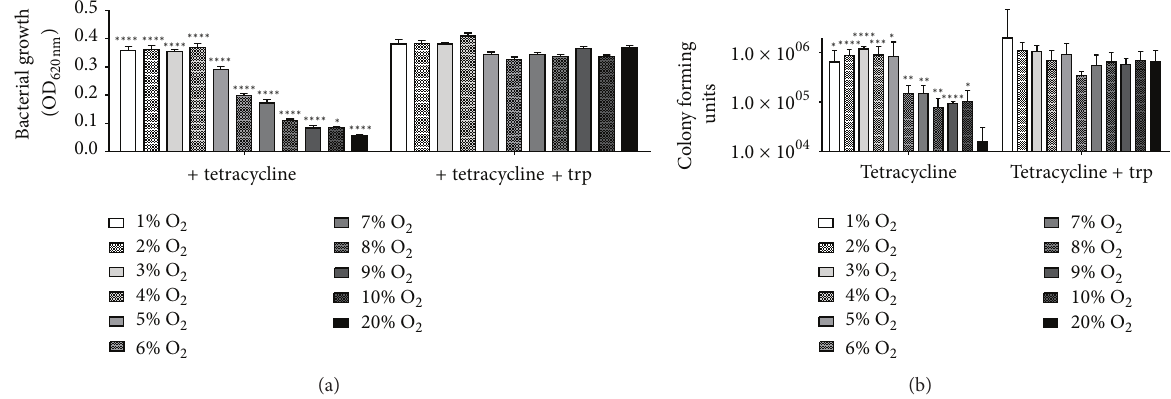
Figure 5: Loss of TDO-mediated antibacterial functions in HeLa-hTDO cells under low oxygen conditions. Infection experiments: HeLa- hTDO cells were incubated under different oxygen conditions (1–20% O 2 ) for 72 h with or without tetracycline (160ng/mL) and afterwards infected with Enterococcus faecalis in the presence or absence of additional tryptophan. (a) After 24 h the bacterial growth was determined by measurement of OD 620 nm , in 3 independent experiments with three replicates each. (b) Determination of colony forming units by serial dilution and summary of 7 independent experiments. Significant alterations of microbial growth as compared to the normoxia control are marked with asterisks ( ∗ 𝑝 ≤ 0.05 ; ∗∗ 𝑝 ≤ 0.01 ; ∗∗∗ 𝑝 ≤ 0.001 ; ∗∗∗∗ 𝑝 ≤ 0.0001 ) and were calculated by a two-tailed, unpaired t -test. The bars indicate the mean value ± SEM (a) or SD (b).